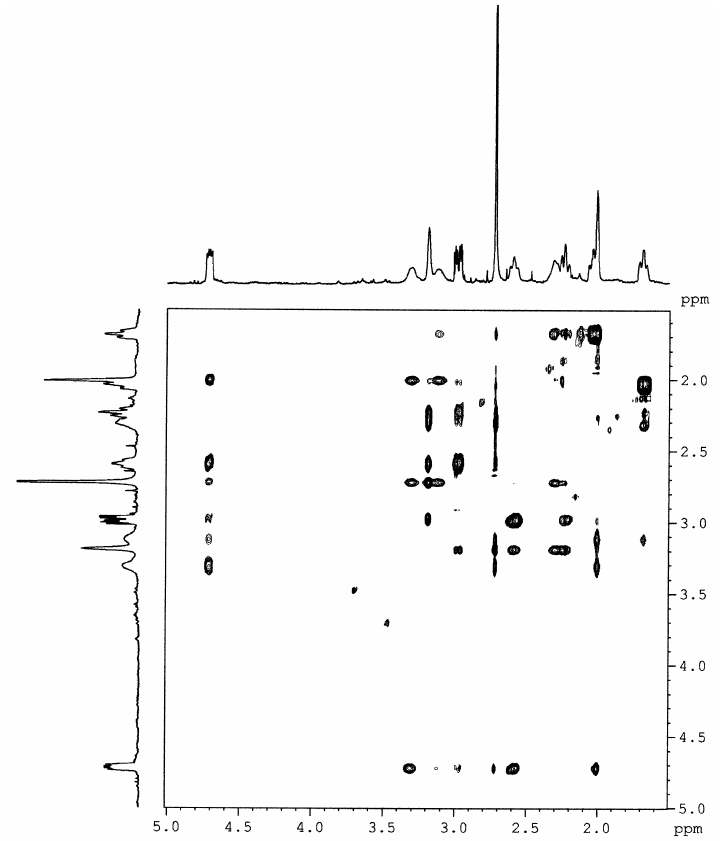
Fig. 7 Section of the NOESY spectrum of compound 8